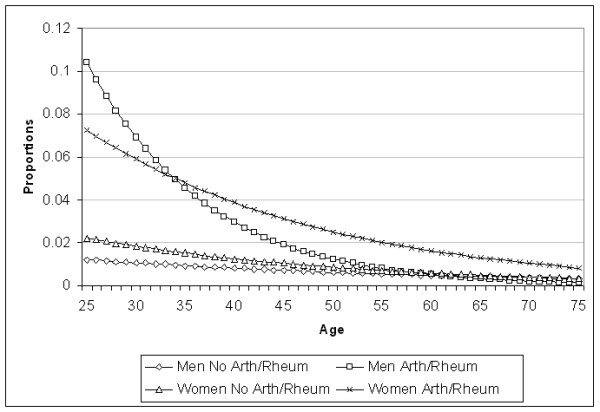
Fitted proportions: logistic regression model for bipolar disorder. The logistic equation is: -3.73 + 3.81 (Arth/Rheum) - 0.027 (Age) + 0.90 (Sex) - 0.063 (Arth/Rheum by Age) - 2.41 (Arth/Rheum by Sex) - 0.012 (Age by Sex) + 0.056 (Arth/Rheum by Age by Sex). Fitted proportions: odds/1 + odds